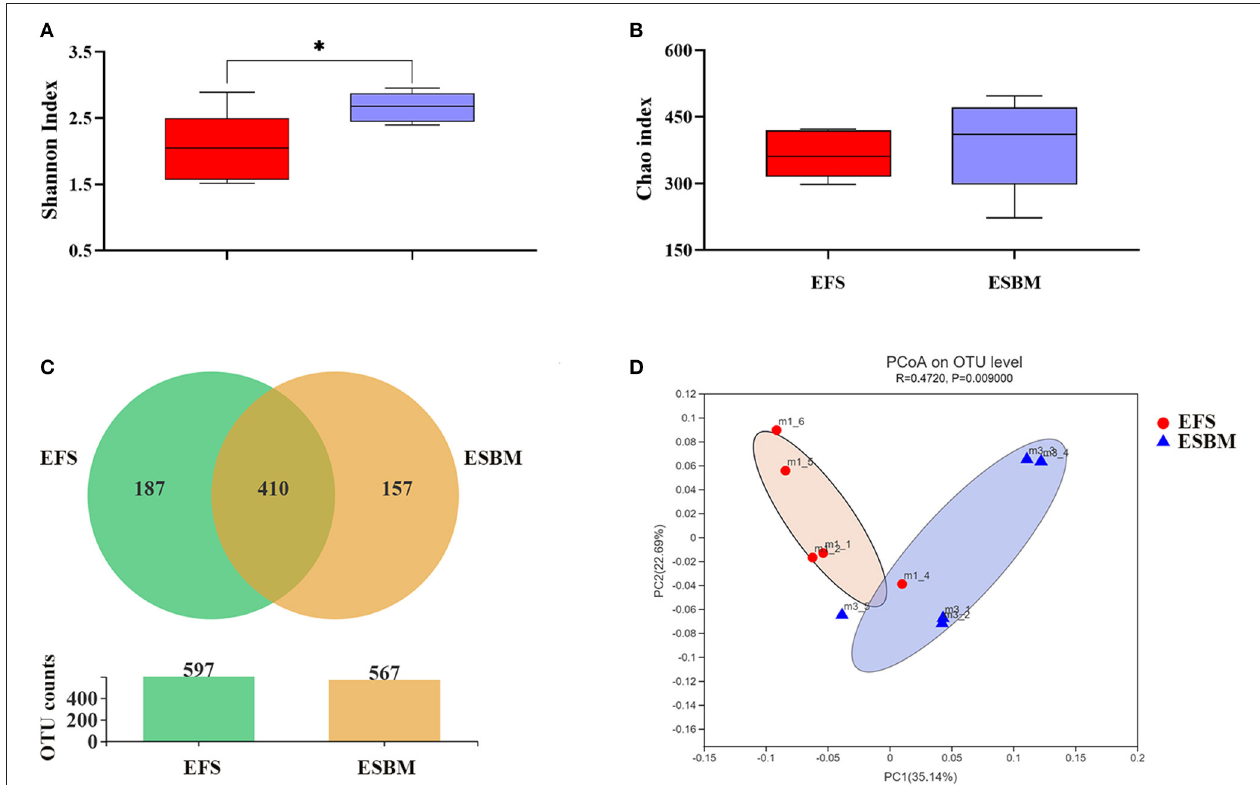
FIGURE 1 | Effects of protein source on the cecal microbes at the OTU (A) , β -diversity (B) and α -diversity indexes including Shannon index (C) and Chao index (D) in piglets. The individual minipig was regarded as the experimental unit, n = 5 for EFS, n = 5 for ESBM. EFS, extruded full-fat soybean; ESBM, enzyme-treated soybean meal. * P <